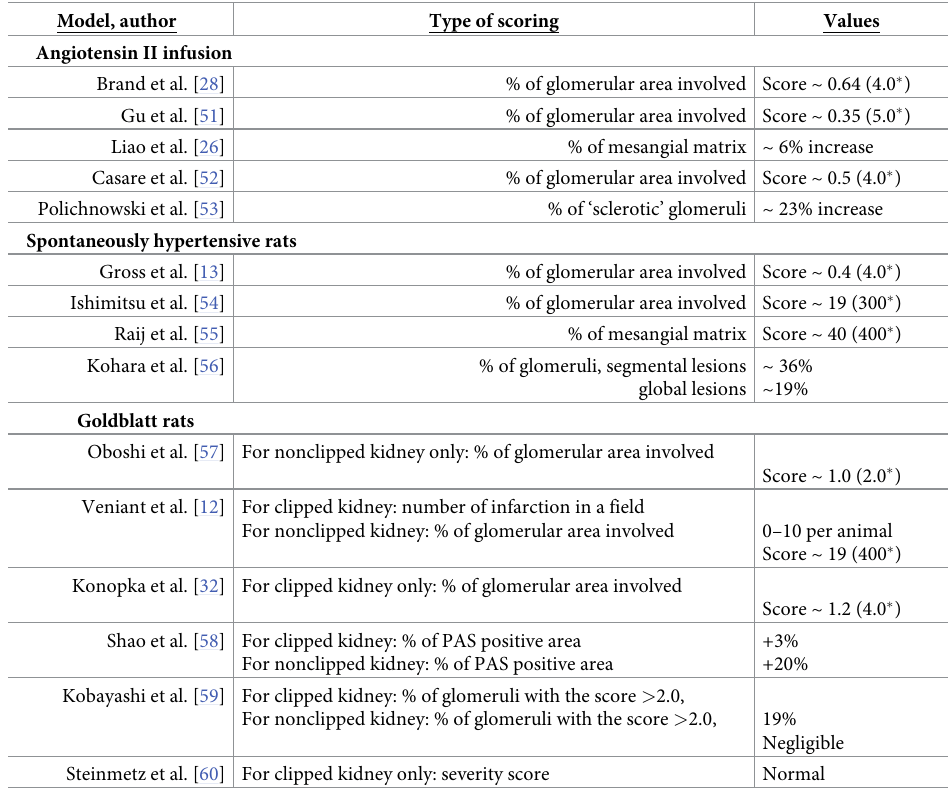
Table 2. Variable parameters for hypertensive glomerulopathy assessment unable quantification and comparison among animal